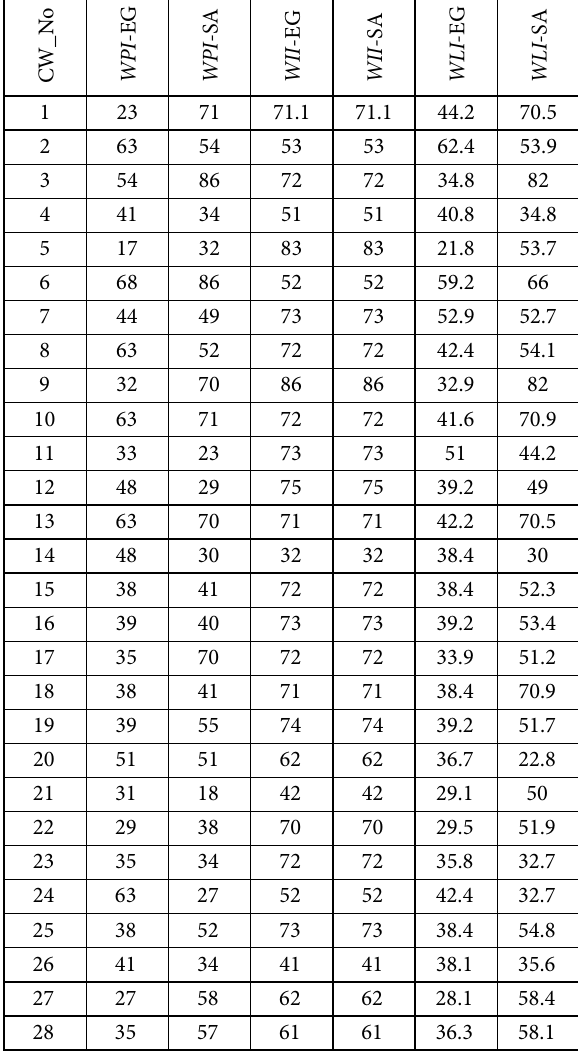
Table 6. Inputs and results indices of Level 01 of the